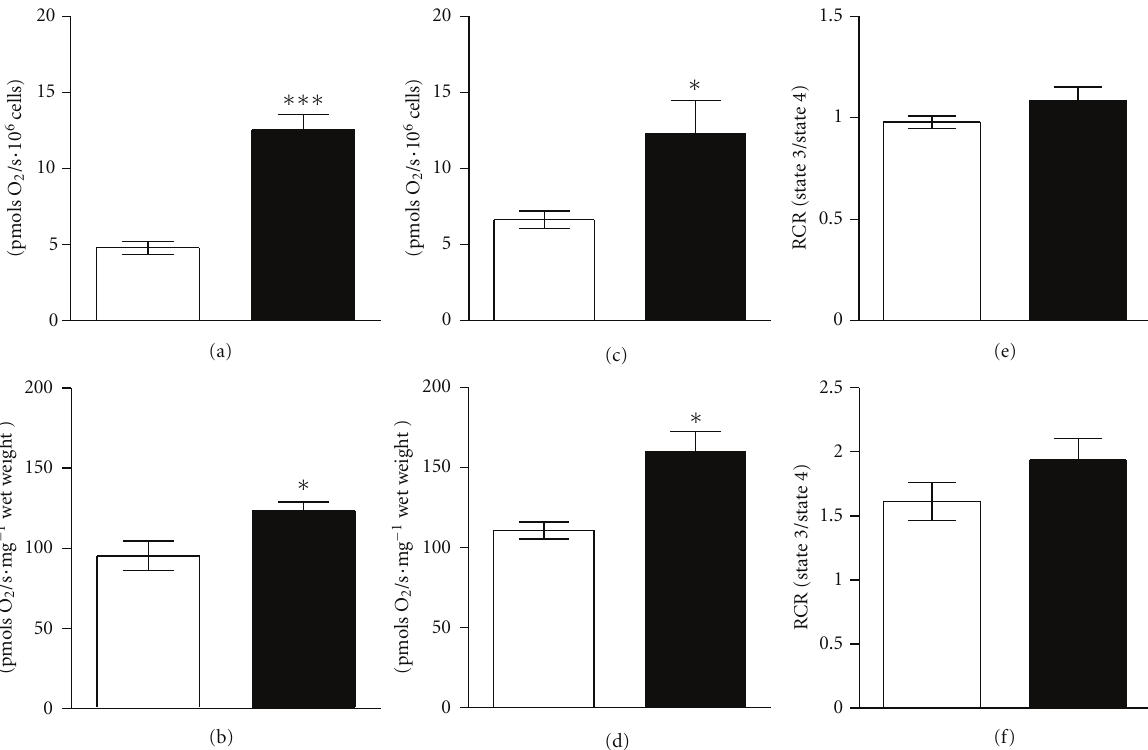
Figure 1: High-resolution respirometry of (a, c, e) lymphocytes and (b, d, f) muscle fibers obtained from control group (white bars) and 24h-fasted group (black bars). Graphics show the maximally stimulated state 3 respiration during (a, b) fatty acid oxidation and (c, d) carbohydrate-linked oxidation. (e, f) Respiratory control ratio (RCR) calculated as state 3/state 4 respiration. Data are mean ± SEM. Asterisks denote significant di ff erence ( ∗ P < 0 . 05 and ∗∗∗ P < 0 . 001) from values for control group as calculated by Student’s t